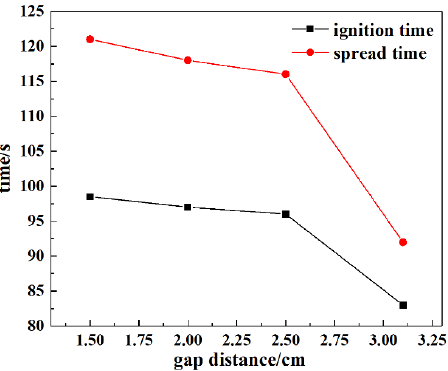
Figure 13. The ignition time and the spread time of cable fire with different gap distances. To quantitatively study the effects of the arc size on the flame propagation, the hori- zontal speed of the flame propagation is obtained with the knowledge of the time delay between the temperature peaks of sensor 2 and sensor 5 and the distance between sensor 2 and the sensor 5. The vertical speed of the flame propagation is obtained with the knowledge of the time delay between the temperature peaks of sensor 1 and sensor 3 and the distance between sensor 1 and sensor 3. Figure 14 shows the horizontal and vertical speeds of flame propagation with different gap distances. When the gap distance increases from 1.5 cm to 3.1 cm, the horizontal speed of the flame increases from 0.128 cm/s to 0.154 cm/s, the vertical speed of the flame increases from 0.356 cm/s to 0.9 cm/s. Obviously, the vertical speed of the flame is greater than the horizontal speed of the flame. This means that the flame propagates faster along the side of the cable. Therefore, as the arc size in- creases, the speed of the flame propagation increases, which leads to the observation of larger flame size of the cable fire and therefore more serious damage of the cable sheath. Figure 14. The horizontal and vertical speed of the flame propagation with different gap distances. 4. Conclusions To understand the cable fire caused by the arc discharge, the effects of arc size on the ignition and flame propagation of the 110 kV cable fire are investigated. When the gap distance between the tips of the electrodes increases from 1.3 cm to 3.1 cm with a constant of arc power, both the length and the surface area of the Jacob’s ladder arc increase signif- icantly, and the gas temperature of the Jacob’s ladder arc decreases slightly. The experi- mental and simulation results of the ignition and flame propagation show that as the arc size increases, the ignition time of the cable fire becomes shorter, the speed of the flame propagation increases significantly, and both the flame size and the damaged area of cable sheath increase. This is mainly due to the significant increase in the contact area between